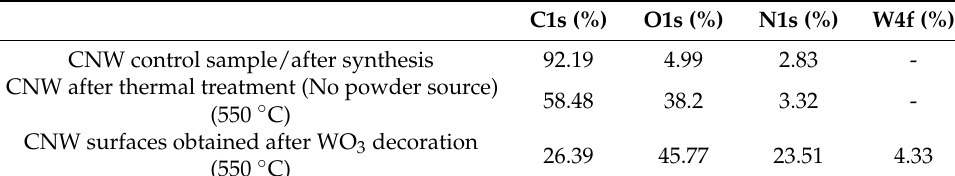
Table 1. The atomic concentration of the obtained hybrid nanostructures in plasma off conditions.